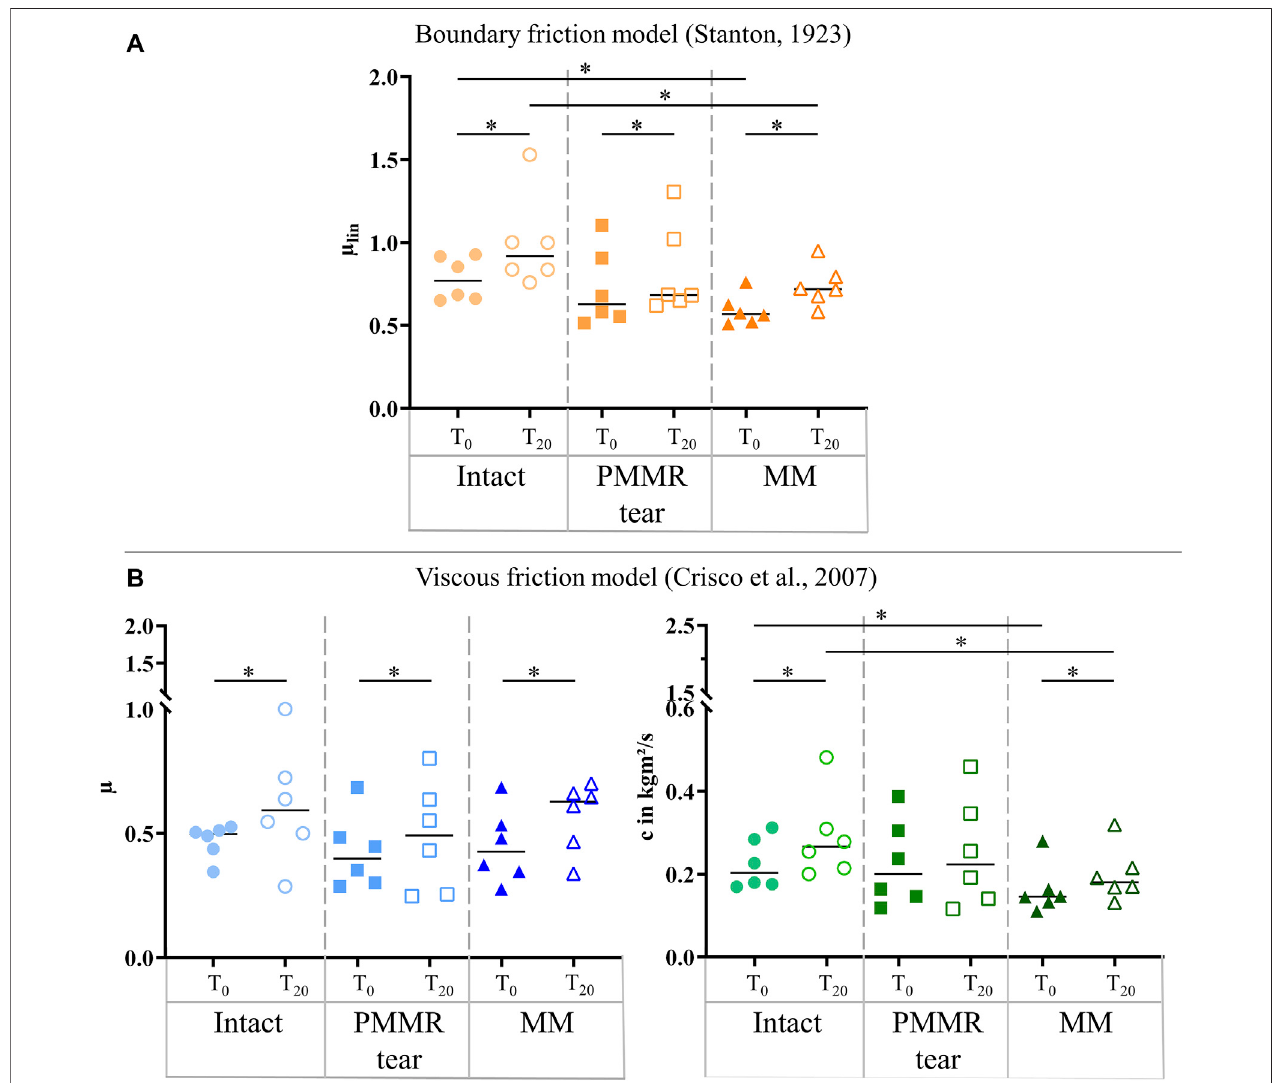
FIGURE7|(A) Scatterplots(medianwithindividualvalues)oftheboundaryfrictioncoef fi cient(µ lin ,symbolcolor:orange)underswingphaseconditions. (B) Scatter plots (median withindividualvalues) oftheviscous friction coef fi cient (µ,symbolcolor:blue)and theviscous dampingcoef fi cient (c, symbol color:green)in kgm 2 /sunder swing phase conditions. Each joint was tested in three consecutive meniscus states: intact (symbol shape: circles), with a posterior medial meniscus root tear (PMMR tear)(symbolshape:squares)andmedialmeniscectomy(MM)(symbolshape:rectangles).Thetestswereperformeddirectlyafterloadingthejointswith250 N(T 0 , fi lled symbols) and after resting under the axial load for 20 min (T fi lled symbols). Non-parametric statistical analyses: n (cid:1) 6; * p < 0.05. 20 , un